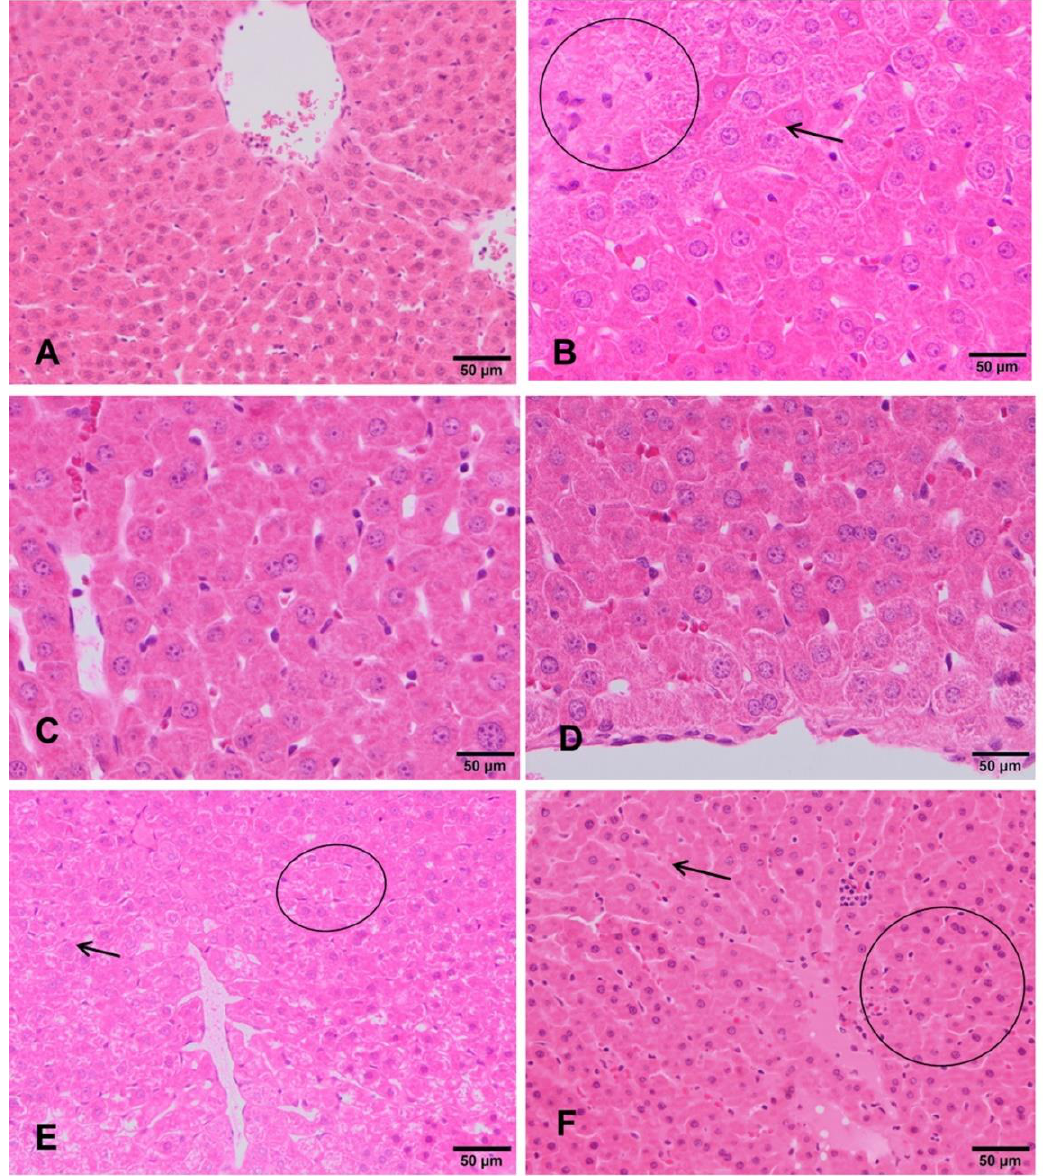
Figure 3. Histopathological changes in the liver of rats exposed to ST-99. Normal hepatic parenchyma is observed in negative control group ( A ). Detail of hepatic cordons of rat exposed to the positive control ( B ), showing glycogenic degeneration (arrow) and abundant polyploid hepatocytes (circle). Rats exposed to 90 and 180mg/kg ST-99 showed an apparently normal liver parenchyma ( C , D ). Rats exposed to 360 mg/kg ST-99 exhibited slight presence hepatic apoptosis throughout the lobule (circle) and glycogenic degeneration (arrow) ( E , F ).